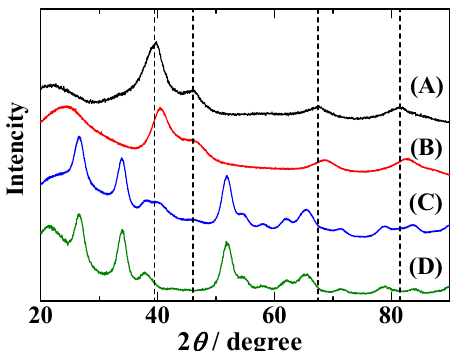
Figure 1. X ‐ ray diffraction patterns of pristine powders of ( A ) commercial Pt/CB (50 wt % ‐ Pt, TEC10E50E); ( B ) Pt 2 Ru 3 /CB; ( C ) Pt 2 Ru 3 /Sb ‐ SnO 2 ; and ( D ) Sb ‐ SnO 2 support. Dashed vertical lines indicate the positions of diffraction peaks for pure platinum.